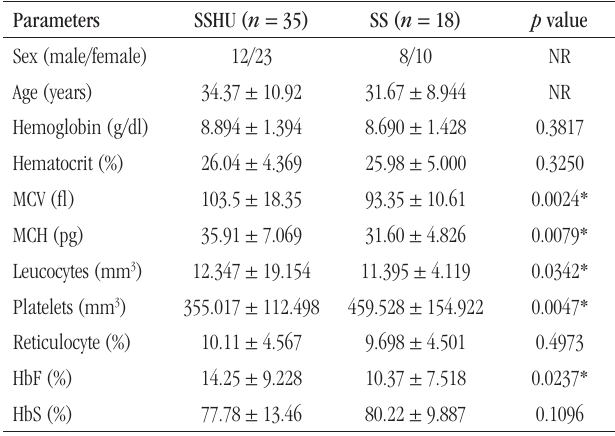
tABLE – Characteristics and clinical details of patients with SCA Parameters SSHU ( n =